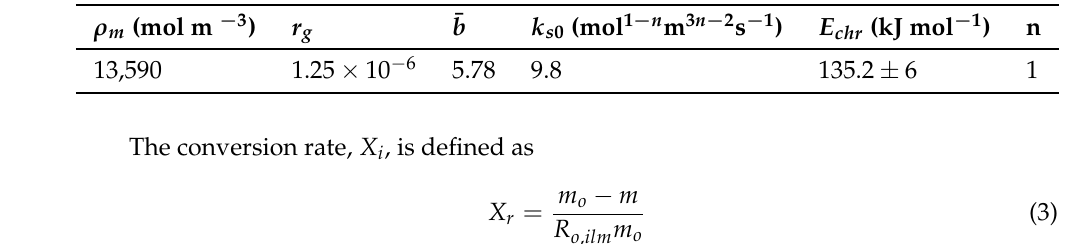
Table 1. Kinetic parameters for reduction and oxidation of oxygen